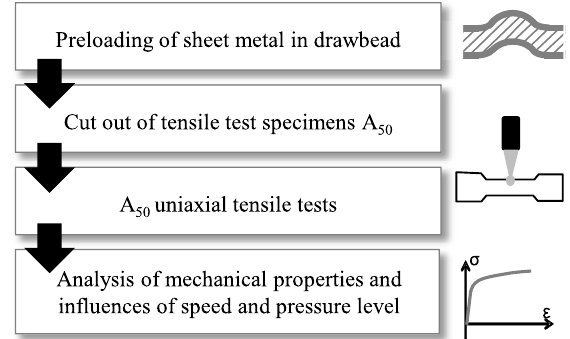
Fig. 1. Strip drawing test with geometry and drawbead height h 1 and h 2 according to [21] in process illustration (a) and used test bed with clamping and drawing unit (b).